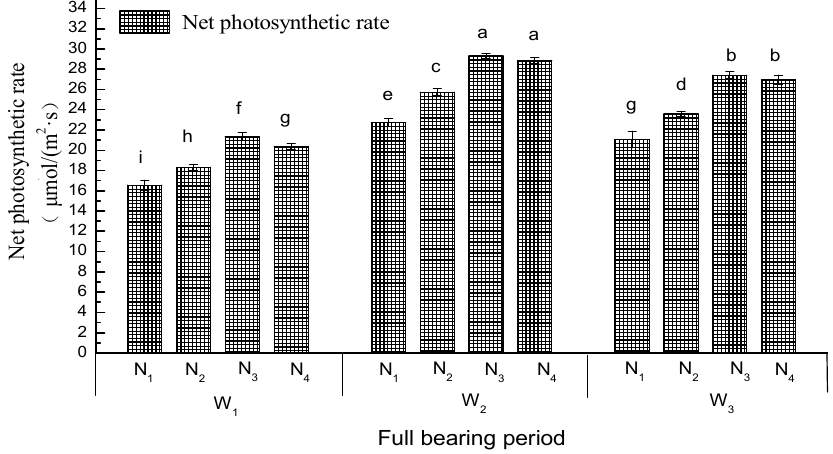
Figure 2. Effects of different water and nitrogen treatments on the net photosynthetic rate at full fruit-bearing stage. Note: if there are the same lowercase letters on the bars, this indicates that there is no significant difference among treatments at the 0.05 level. W 1 , 0.75 actual evapotranspiration (ETc); W 2 , 1.00ETc; W 3 , 1.25ETc. N 1 (120 N hm −2 ), N 2 (220 N hm −2 ), N 3 (320 kg N hm −2 ), N 4 (420 kg N hm −2 ).